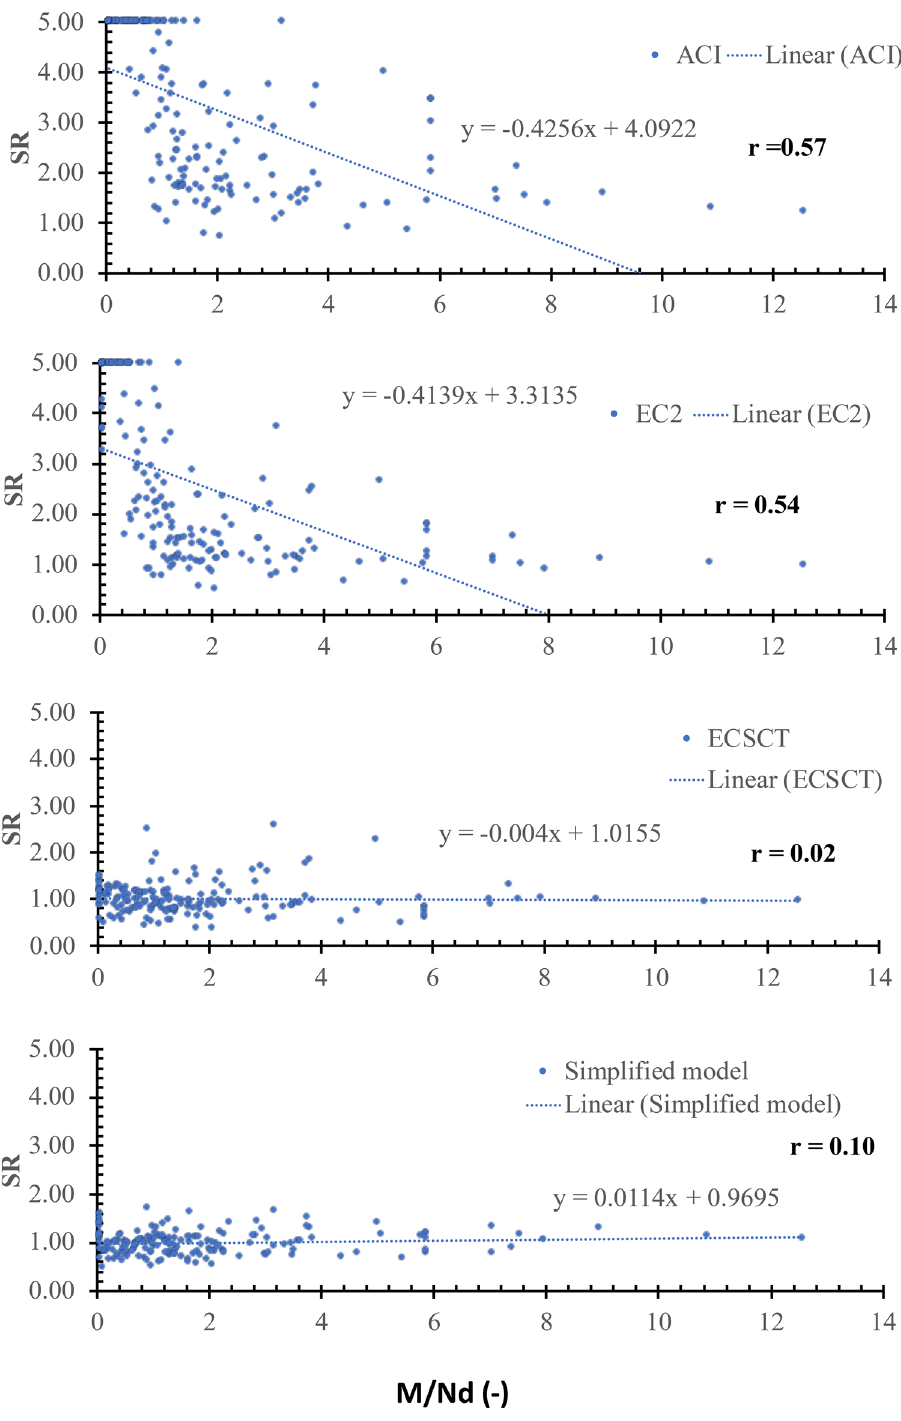
Figure 10. SR using various methods versus the M /